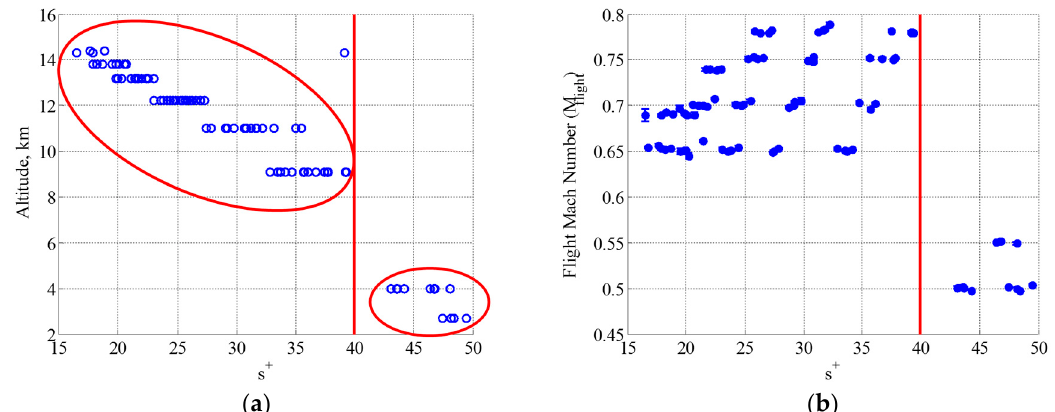
Figure 4. Relationship between each variable and test conditions: ( a ) flight altitude and s + ; ( b ) Mach number and s + .